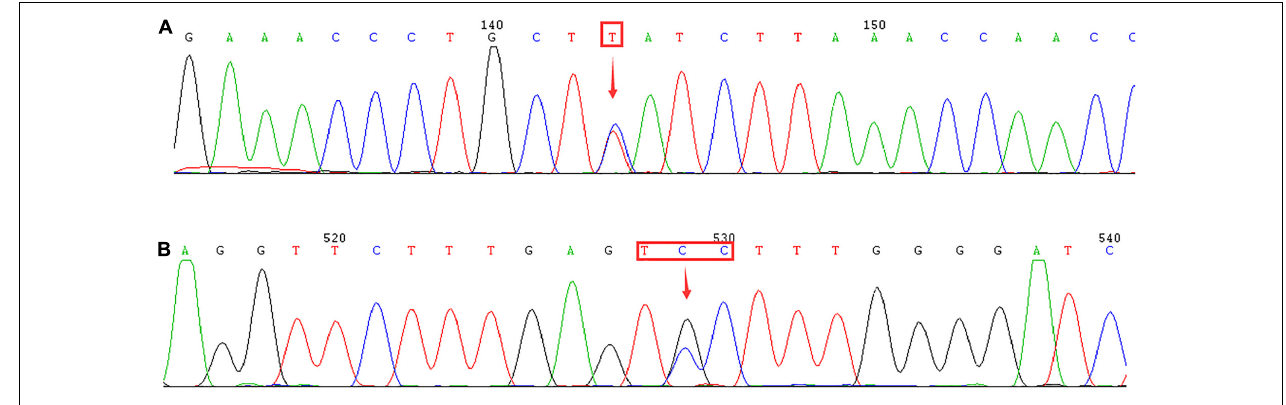
FIGURE 3 | Identification of δ -globin gene mutation using DNA sequencing. Arrows indicate the location of the mutations. (A) –77(T > C) (HBD:c.-127T > C) mutation in the HBD gene. (B) Novel mutation of CD44(TCC > TGC) (HBD:c.134C > G) in the HBD gene.